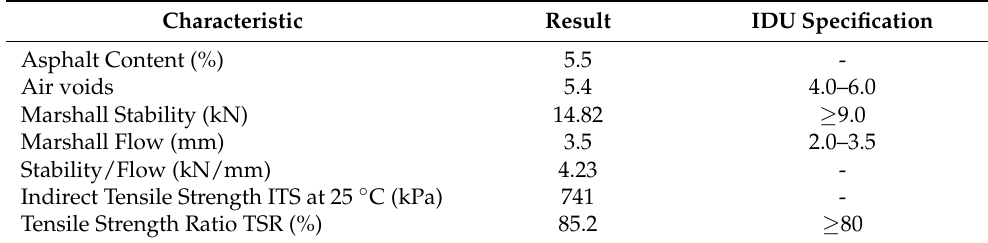
Table 1. Asphalt mixture characteristics.